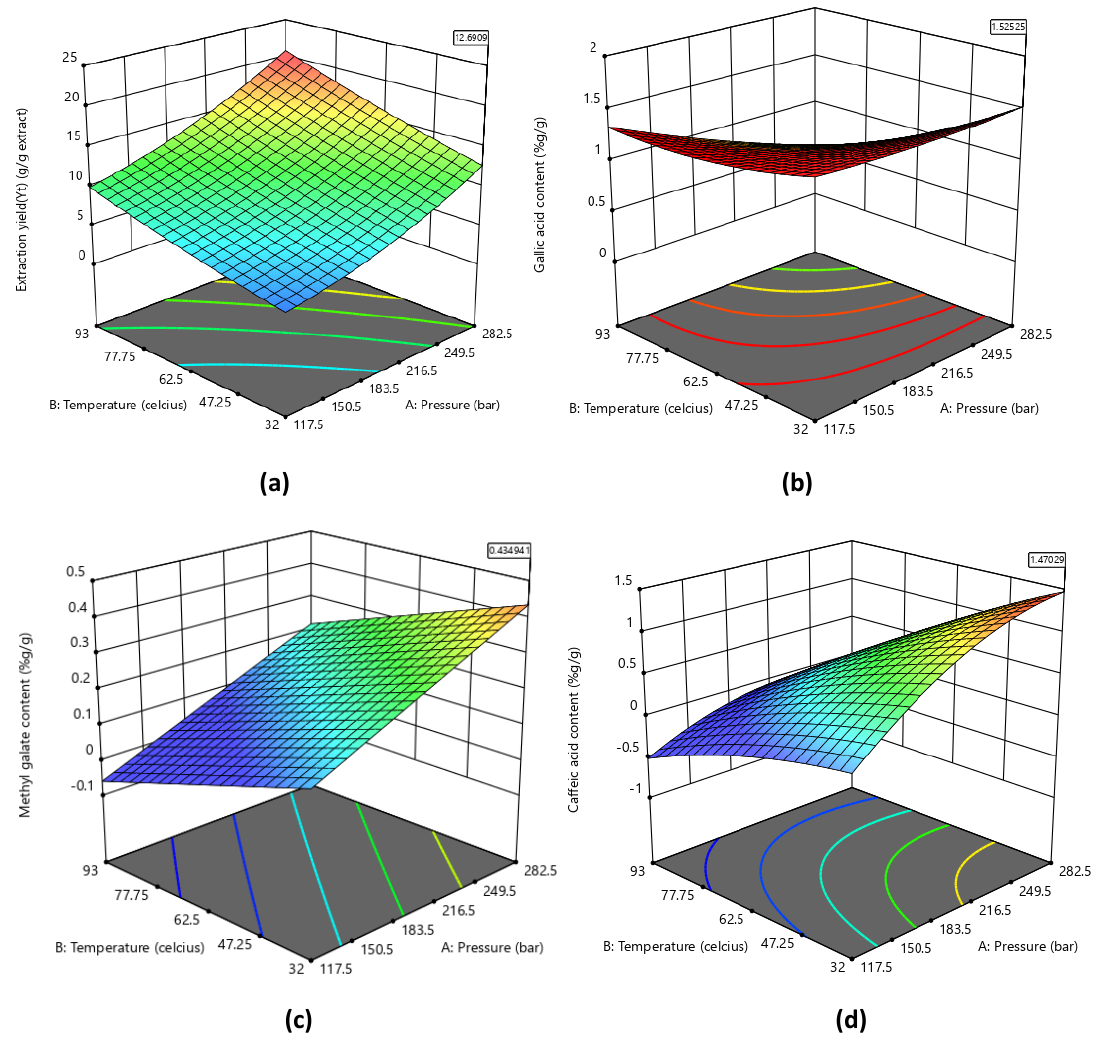
Figure 1 a-d Figure 1. Effect of pressure and temperature on ( a ) extraction yield, ( b ) gallic acid content, ( c ) methyl gallate content, and ( d ) caffeic acid